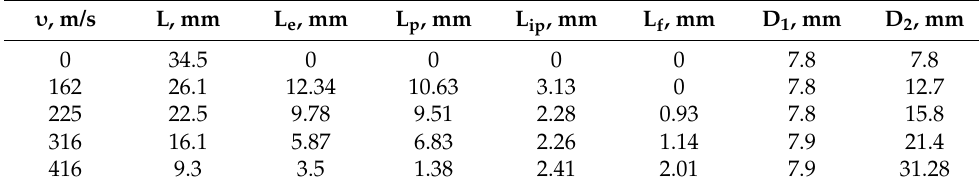
Figure 5. Schematic of the specimen deformation after impact onto a rigid wall. Table 2. Lengths of the deformation zones in specimens. Table 2. Lengths of the deformation zones in